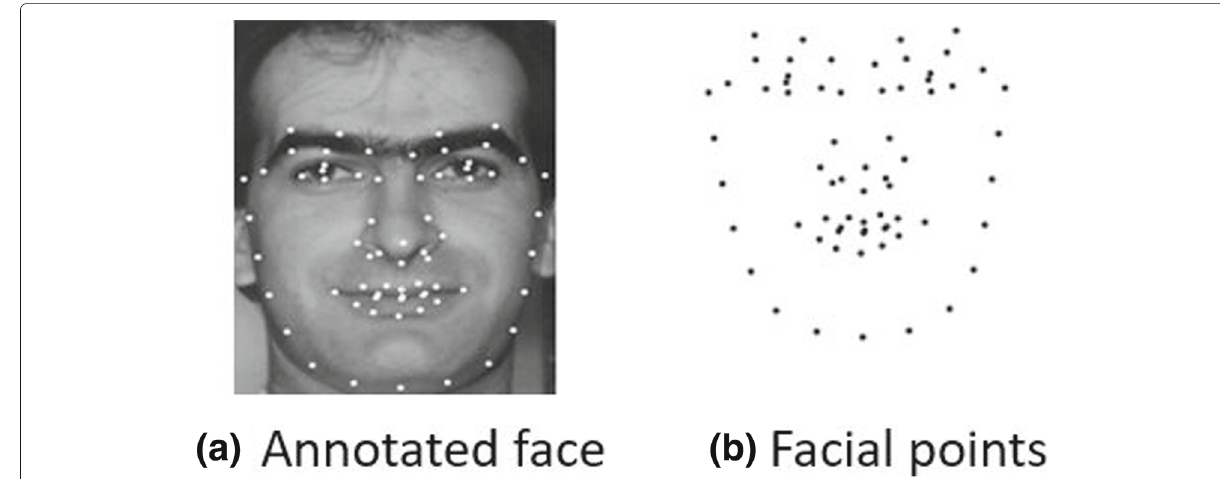
Fig. 4 a , b Facial shape and appearance annotation